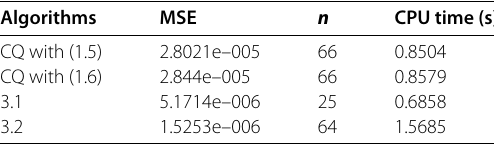
Table 1 Results of different stepsizes and algorithms for Figure 1 Algorithms MSE